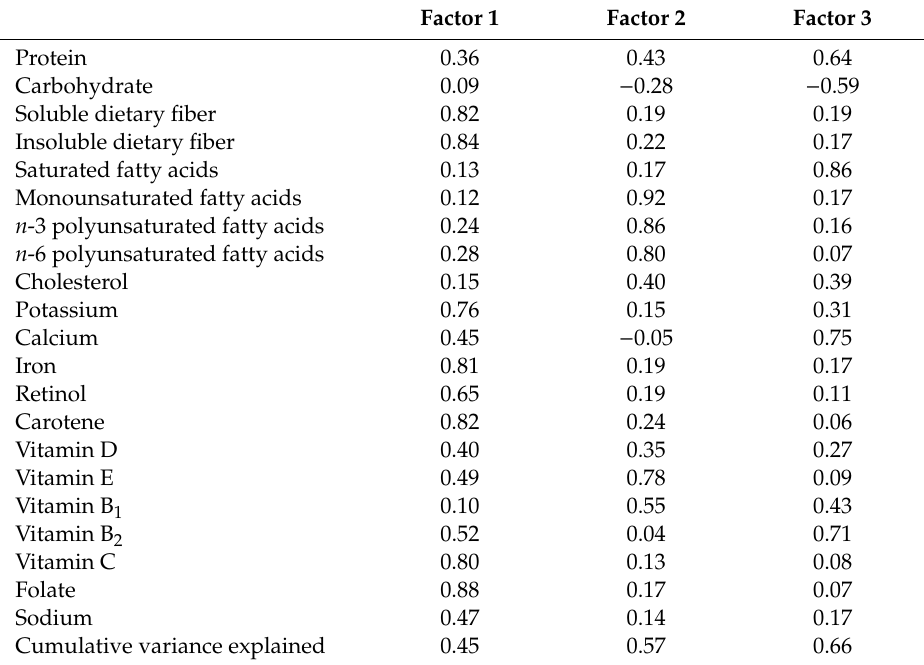
Table 2. Factor loading matrix for selected nutrient patterns.